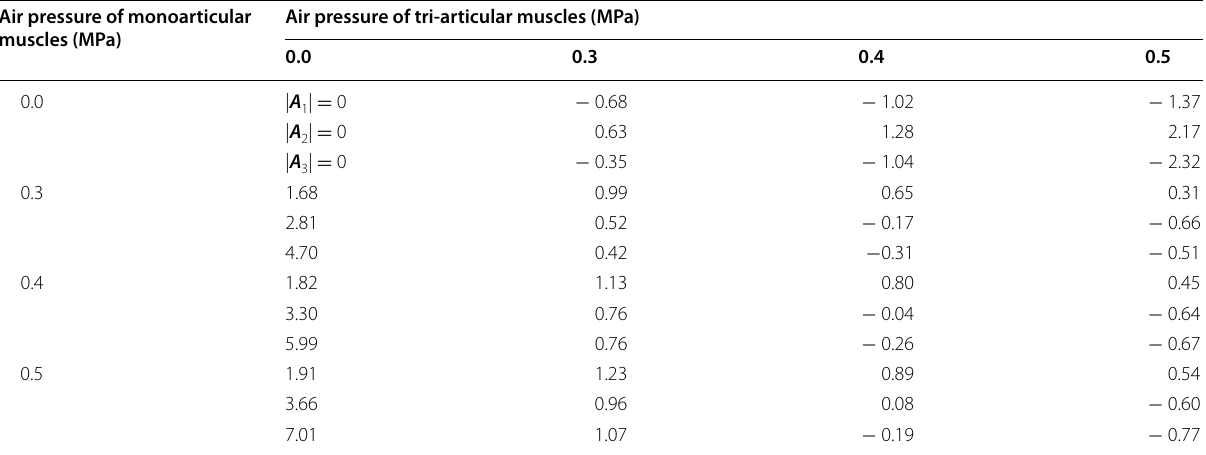
Table 3 Determinants of A 1 , A 2 , and A 3 indicating stability in different cases Air pressure of monoarticular Air pressure of tri‑articular muscles muscles (MPa)